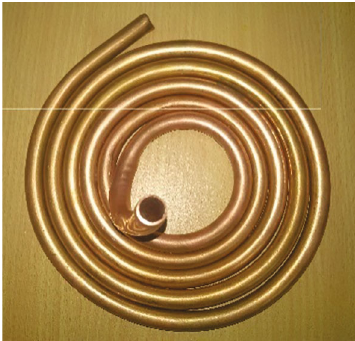
Figure 13: Modi fi ed spiral coil tubular thermal absorber.